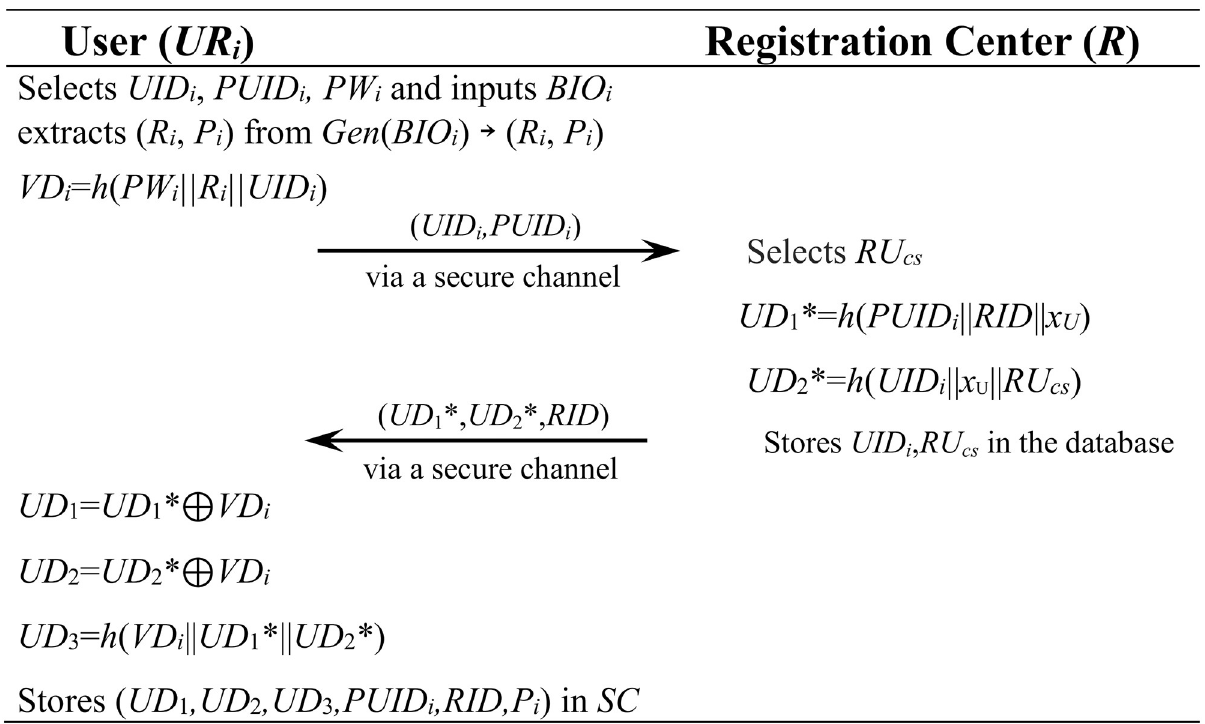
Fig 1. User registration phase in the proposed scheme.